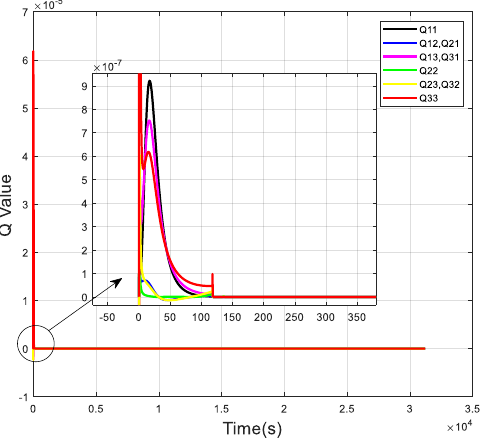
Figure 12. Q value of AUKF algorithm.